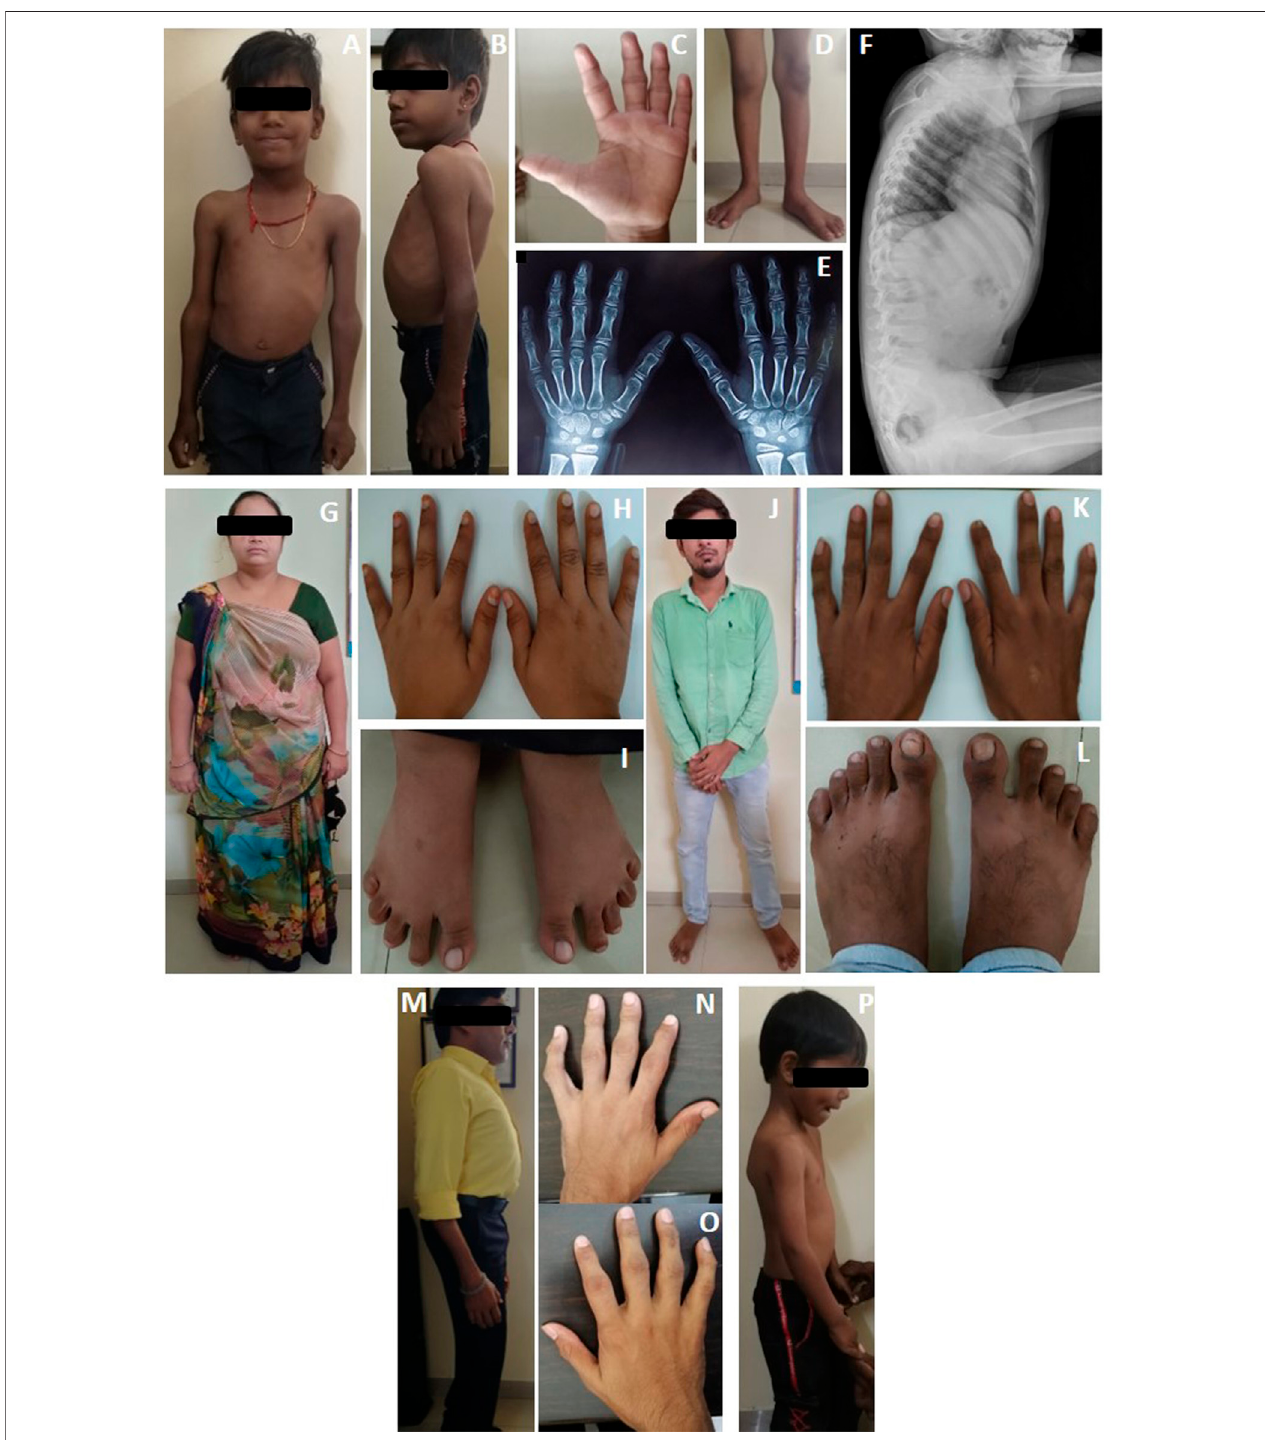
FIGURE2| Clinicalphotographsandradiographsofproband ’ s( A – F )case1,( G – H )case1 ’ smother,( J – L )case1 ’ sfather,( M – O )case2,and( P )Case3.Case1is observed with ( A ) chest deformity and enlarged elbow joints; ( B ) scoliosis; ( C ) deformities of interphalangeal joints; ( D ) knocked knees; ( E ) radiograph anterior-posterior view, showing osteopenia; ( F ) anterior beaking of vertebrae. ( G – I ) Clinical picture of mother (carrier) of case 1; ( J – L ) clinical picture of father (carrier) of case 1. Case 2 is observed with (M) scoliosis and (N,O) clinodactyly with deformities of interphalangeal joints. Case 3 is observed with (P) mild scoliosis.